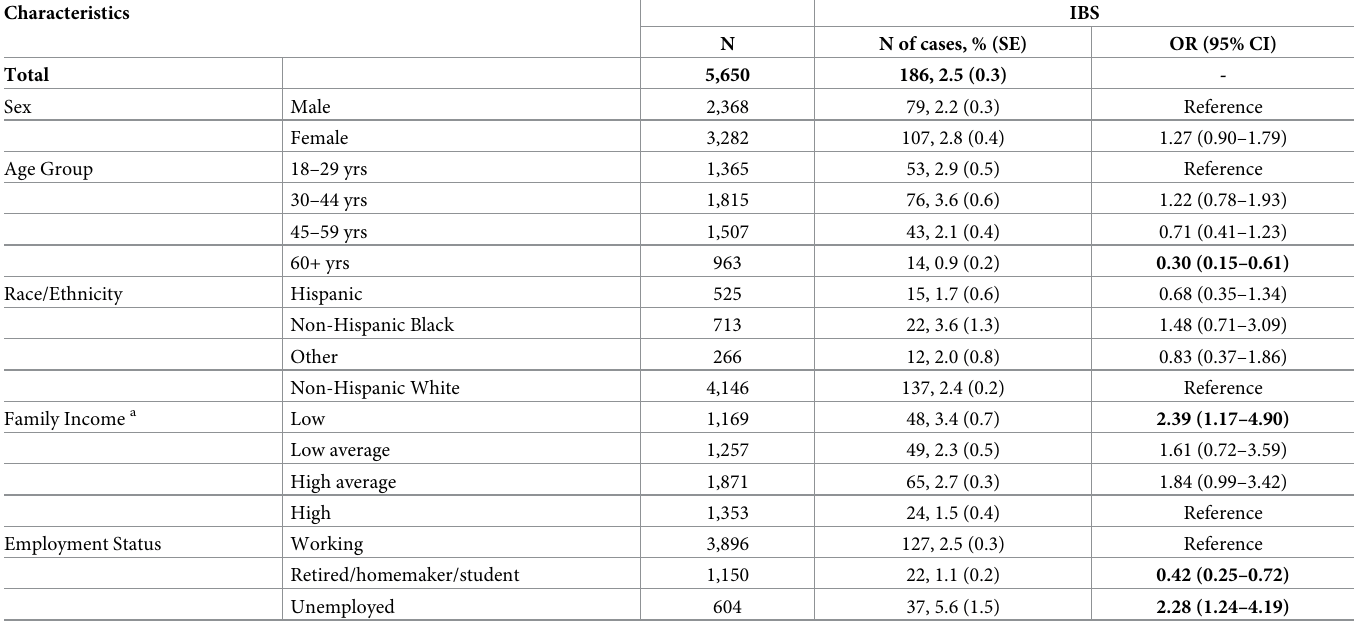
Table 1. Demographic and social characteristics of Irritable Bowel Syndrome in NCS-R Part II survey. Characteristics